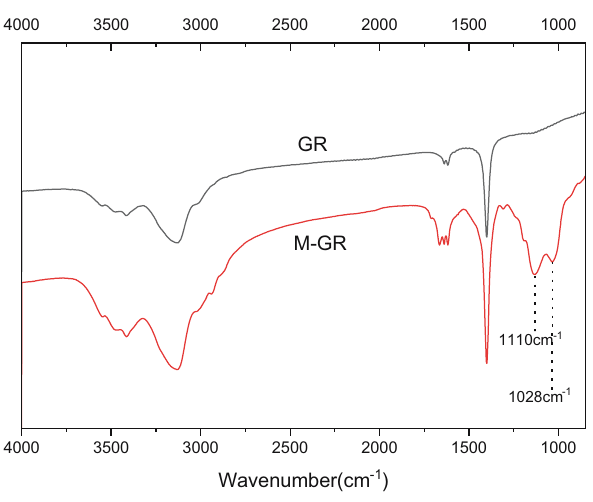
Figure 2: FT - IR spectra of GR and M - GR.